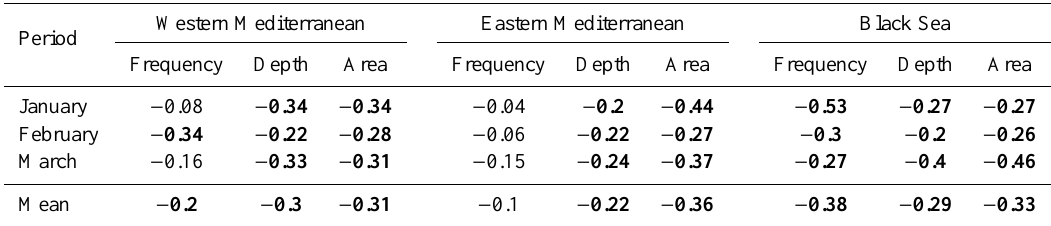
Table 1. Monthly correlation coe ffi cients between the characteristics of cyclones in all studied regions and the NAO index. Coe ffi cients significant on 95% confidence level are set o ff in bold font.